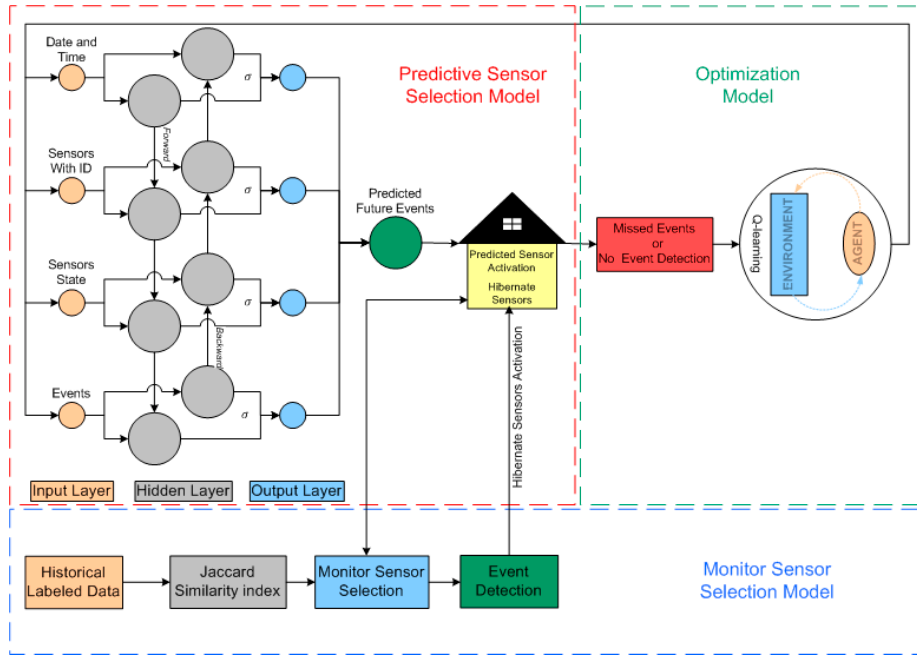
Figure 4. System architecture.